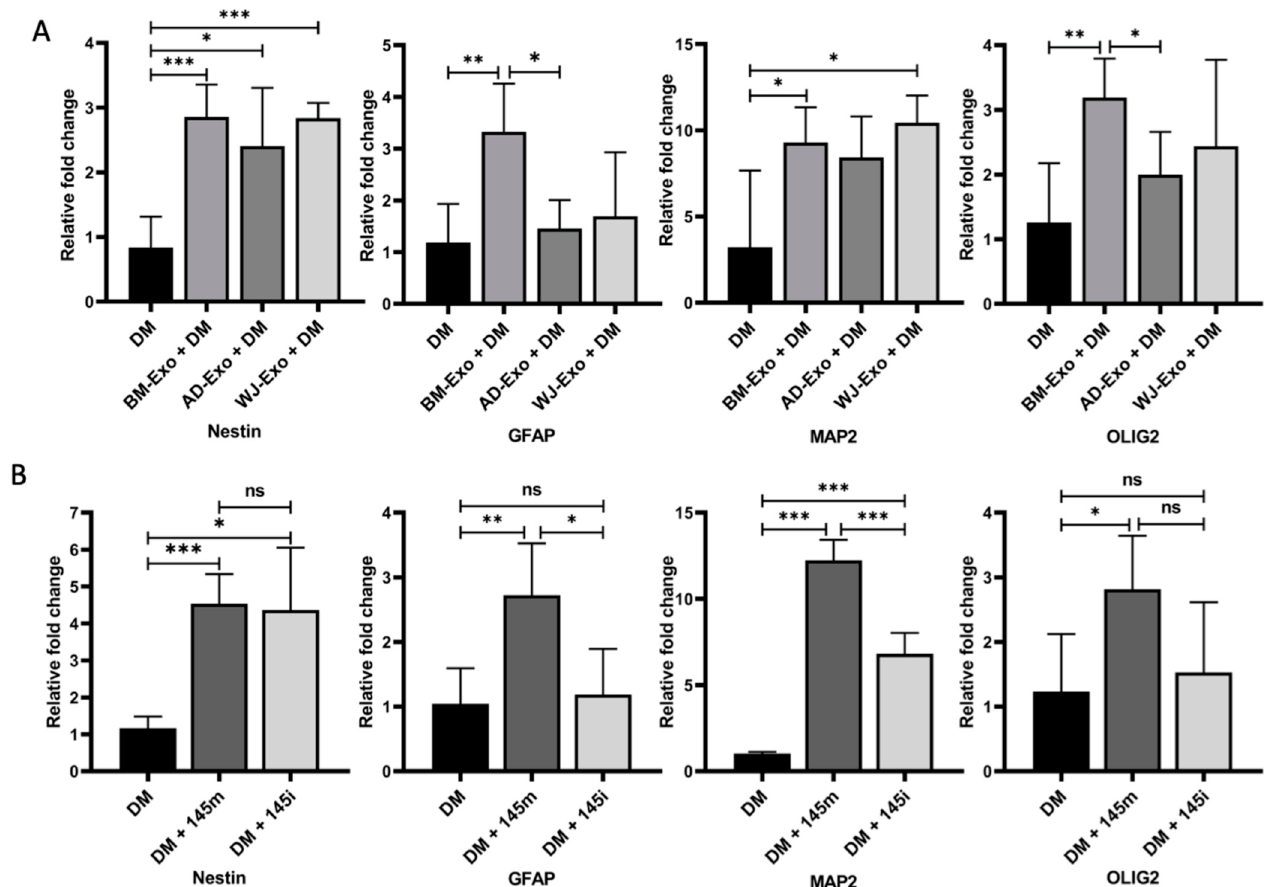
Figure 4. Effect of exosomes and miR ‐ 145 on neurogenesis. ( A ) C17.2 cells were incubated with differentiation media (DM) and 30 μ g of exosomal protein for 7 days. Cells were lysed, and the expression of differentiation markers was measured using RT ‐ PCR. ( B ) Cells were over ‐ expressed and inhibited with mir ‐ 145 ‐ 5p mimic or inhibitors. After 6 h of treatment, cells were washed and incubated with differentiation media for 7 days. Neurogenesis markers were checked by qRT ‐ PCR. Data are represented as mean ± SD; * p < 0.033, ** p < 0.002, and *** p < 0.001; ns = non ‐ significant; DM = Differential media; 145m = miR ‐ 145 ‐ 5p Mimic; 145i = miR ‐ 145 ‐ 5p inhibitor.